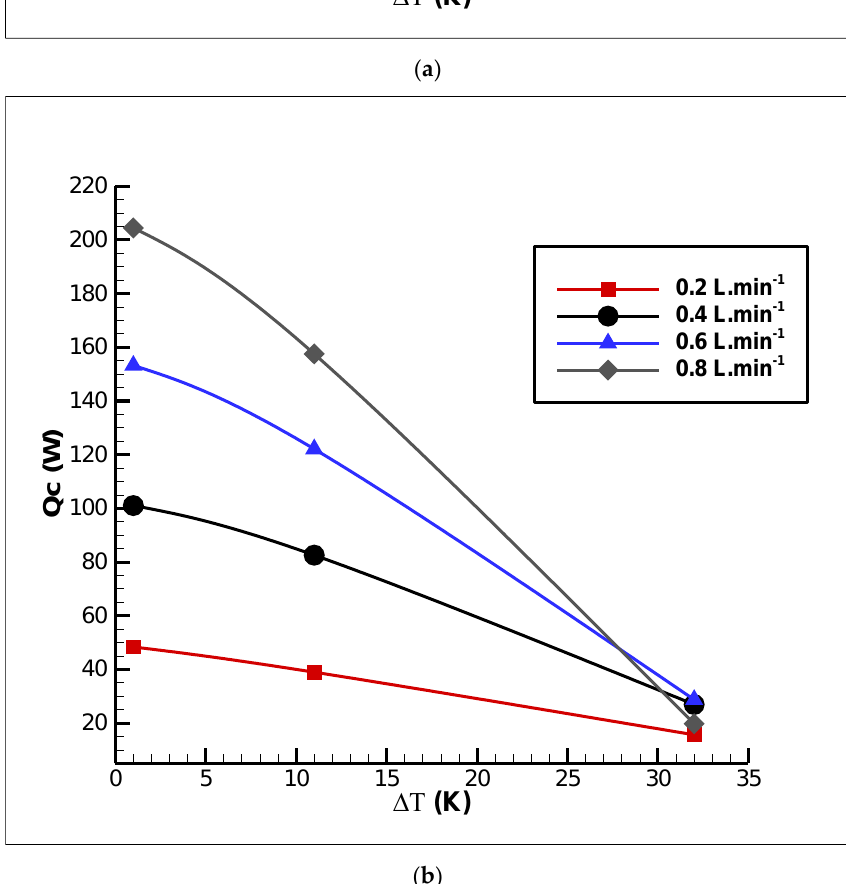
Figure 10. The effects of the span temperature variation on the coefficient of performance ( a ) and Figure 10. The e ff ects of the span temperature variation on the coe ffi cient of performance ( a ) and refrigeration capacity ( b ). refrigeration capacity ( b